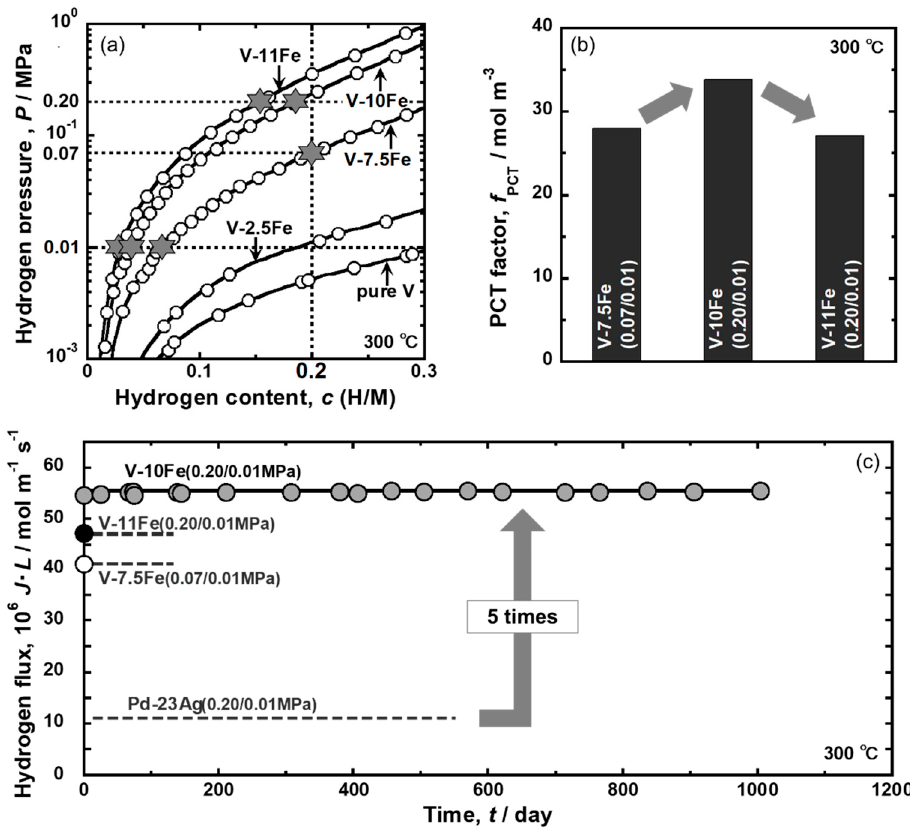
Figure 14. ( a ) PCT curves of pure V [47] and V-Fe alloys at 300 °C, ( b ) PCT factors for each alloy at each condition represented by star symbol ( ☆ ) in ( a ), and ( c ) time dependence of hydrogen flux normalized by the inverse of membrane thickness ( J·L ) for Pd-27 mol%Ag-coated V-10 mol%Fe alloy membranes at 300 °C. The experimental results for V-7.5 and V-11 mol%Fe alloy membranes under the conditions represented by the star symbols in ( a ) and the estimated value for Pd-23 mol%Ag alloy under the same condition as V-10 mol%Fe alloy are also shown in the figure [28].